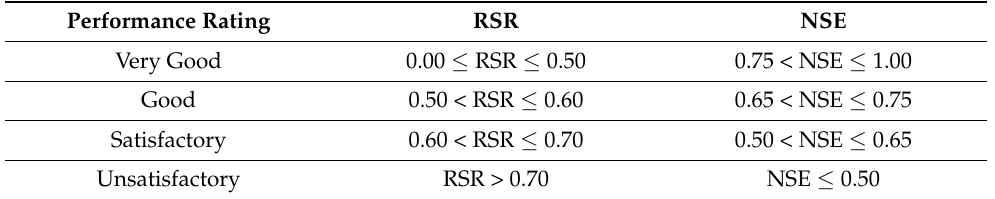
Table 5. General performance ratings